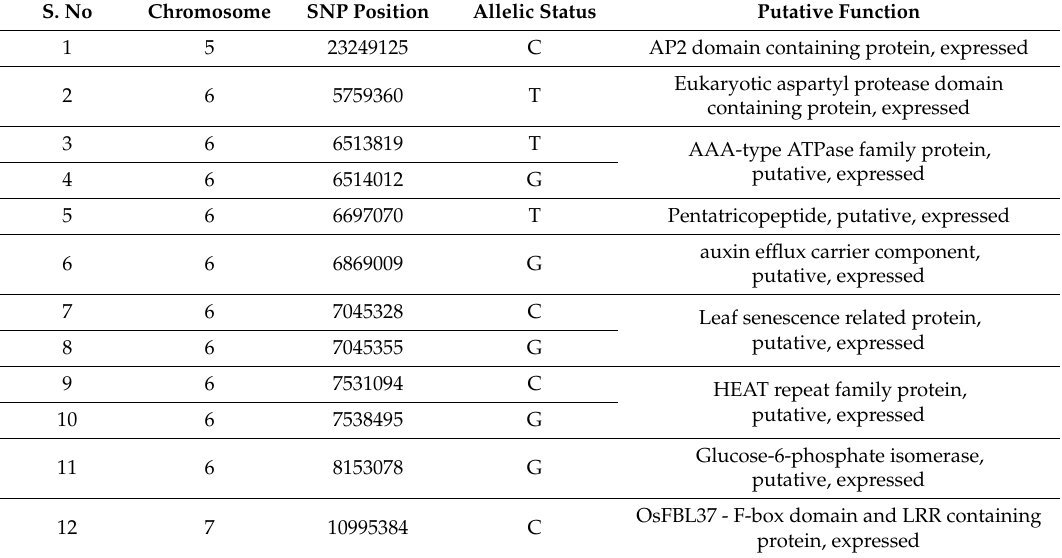
Table 4. Allelic status of the significant QTNs that are contributing to resistance in the agronomically superior RiMi lines (MIB_4393, MIB_3693, MIB_4077 and MIB_4570).